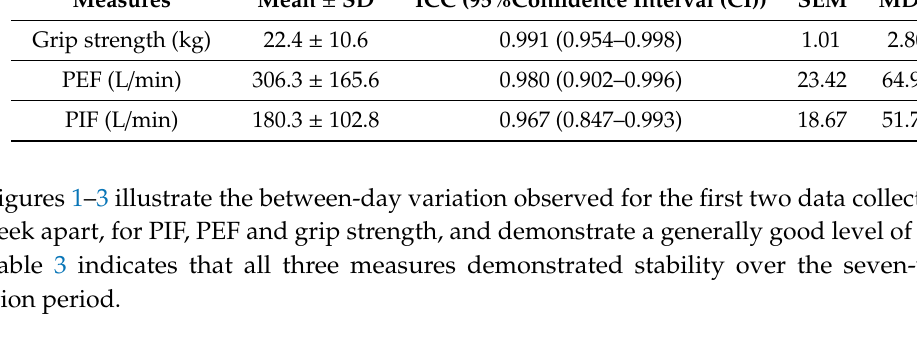
Table 3. Between day variation (all 5 time points) in grip strength, PEF and